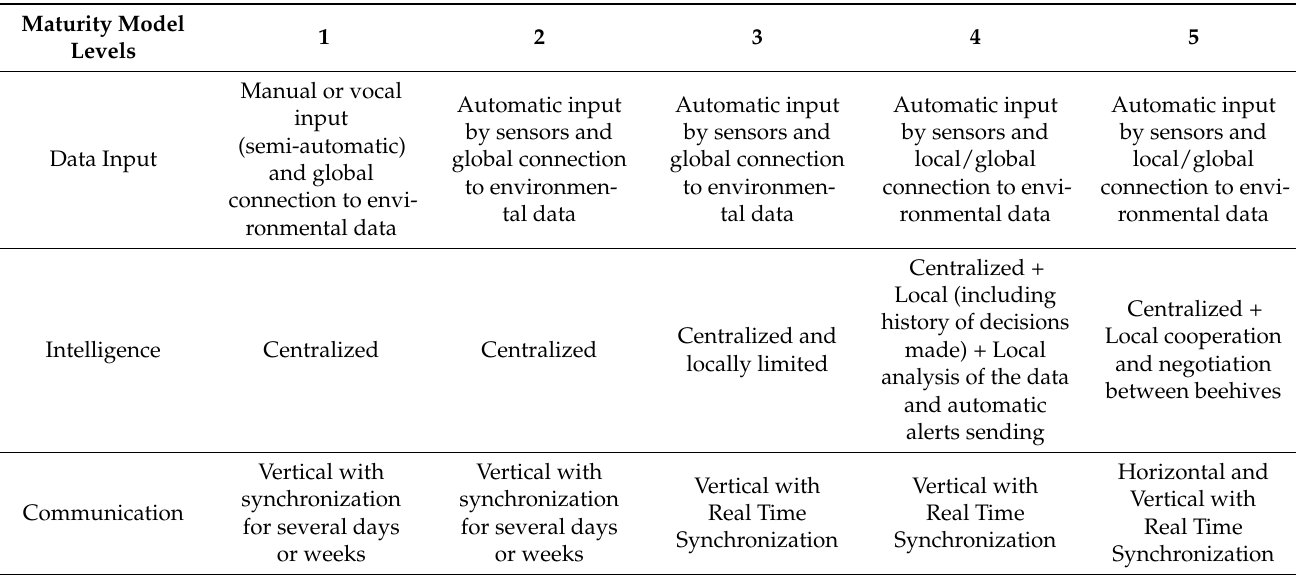
Table 1. Maturity model levels adapted for smart